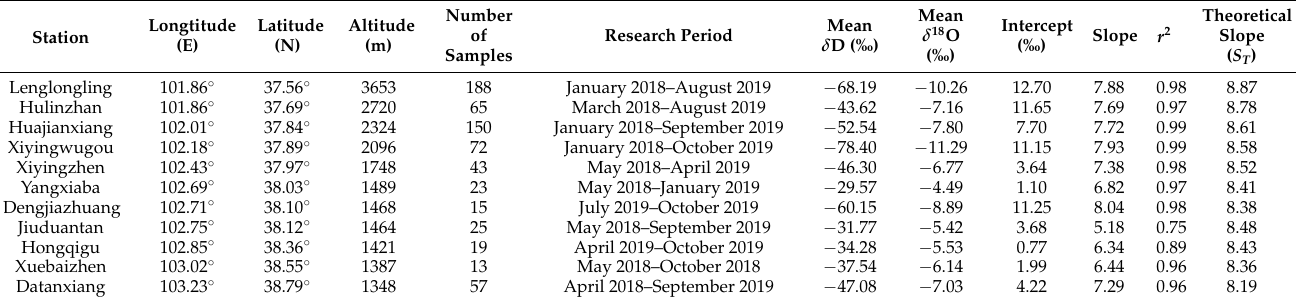
Table 1. Local meteoric water line at each sampling point in Shiyang River